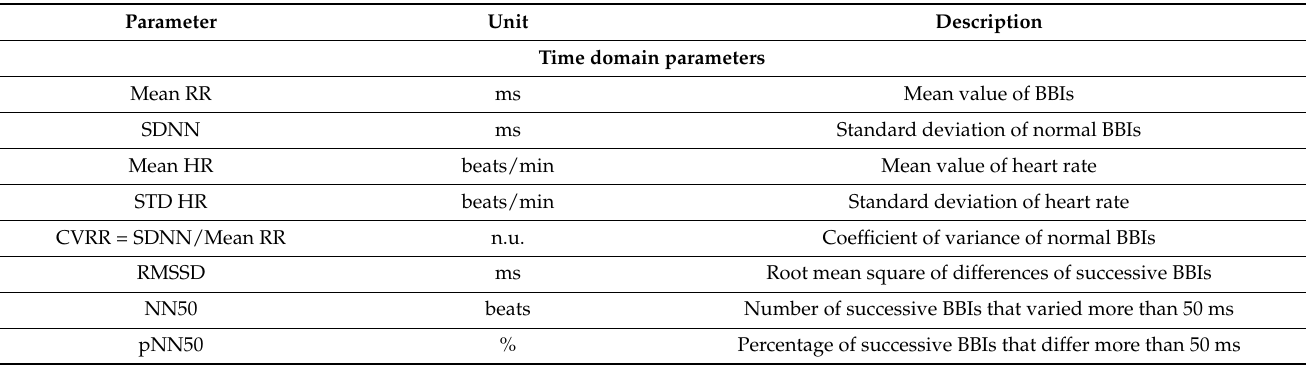
Table 1. Heart rate variability (HRV)